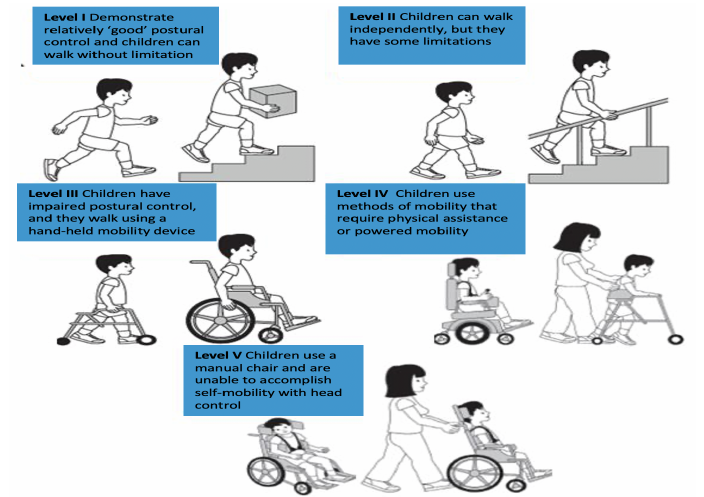
Figure 1. Cerebral palsy